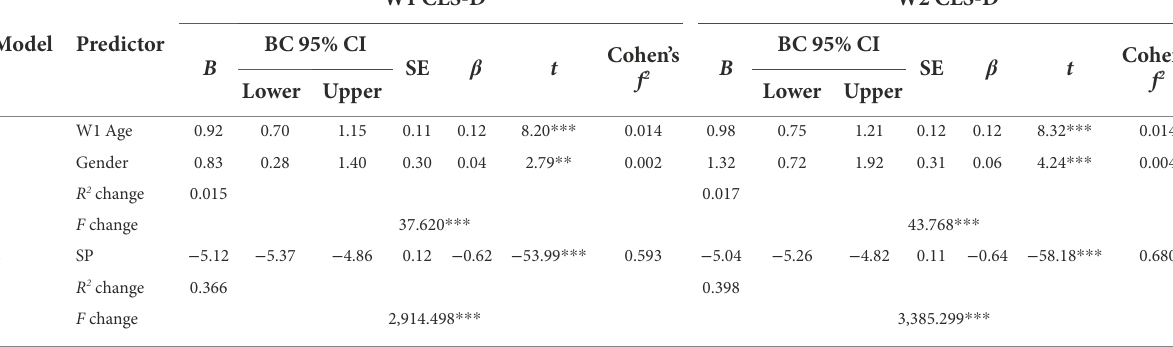
TABLE 5 Cross sectional predicting effects of life meaning (SP) on depression (CES-D).